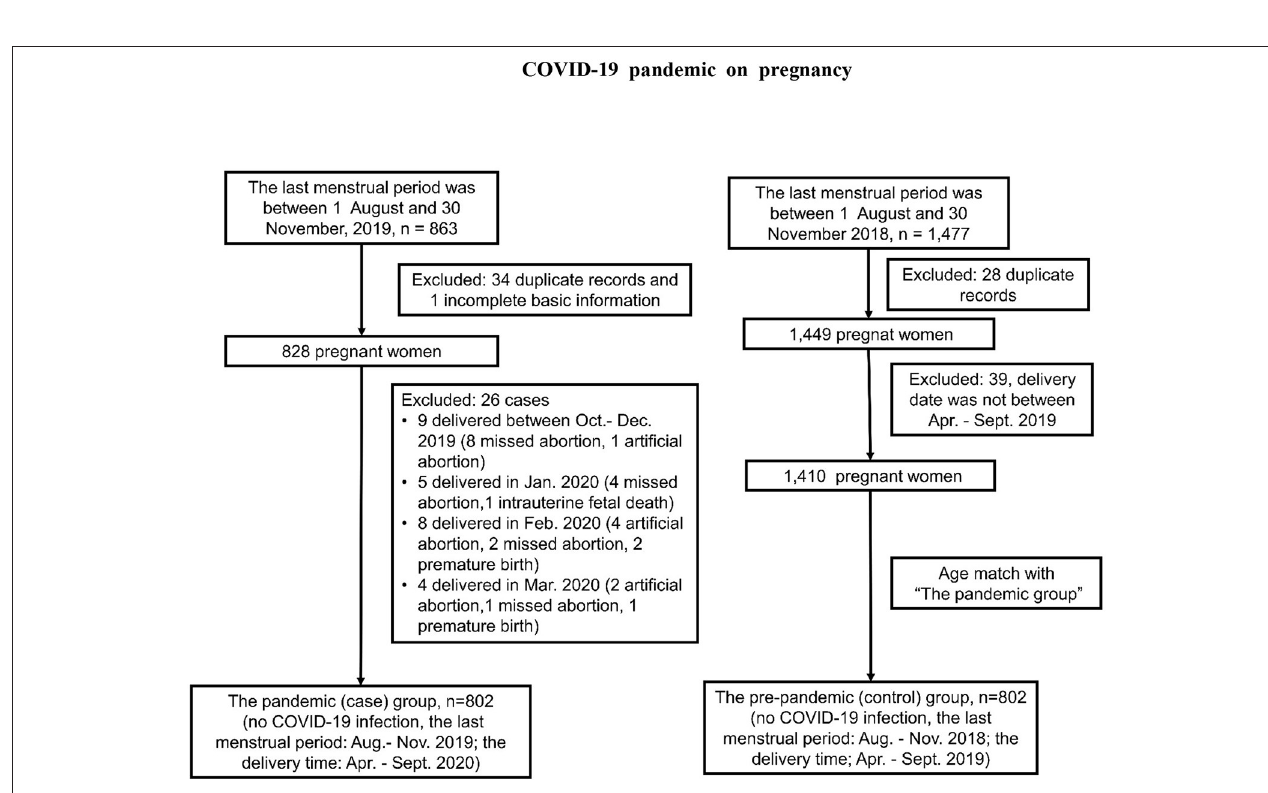
FIGURE 2 | A flowchart of participant selection and exclusion in this study, China, 2018-2020.